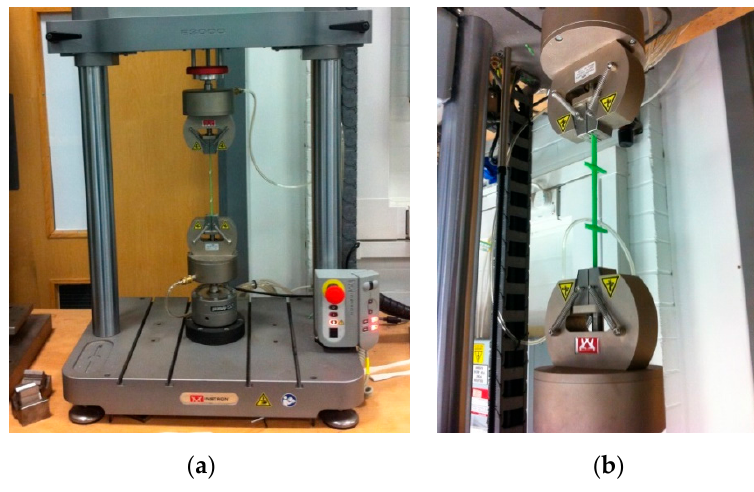
Figure 5. Fatigue testing ( a ) Fatigue testing machine; ( b ) GFRP specimen under test.